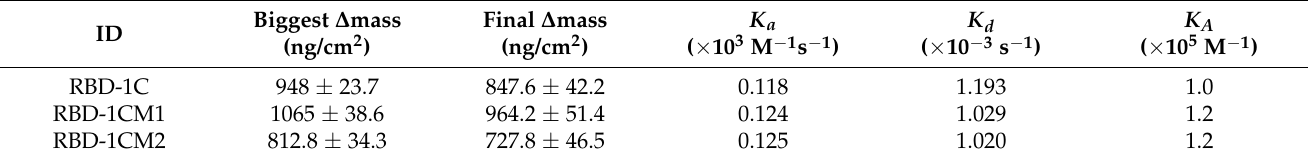
Figure 7. Representative time dependencies of ∆ mass changes in the aptamer-immobilized chips responding to the S protein. The S protein started to flow over the chip surface at arrow A (at 42 s) and the flow was changes to 1X PBS buffer at arrow B (at 282 s). Table 2. Results of QCM experiments for RBD-1C, RBD-1CM1, and RBD-1CM2 aptamer against the S protein. Under the experimental conditions, the average values of mass changes and kinetic parameters are presented as follows. k a : association constant; k d : dissociation constant; K A = k a / k d (binding affinity).